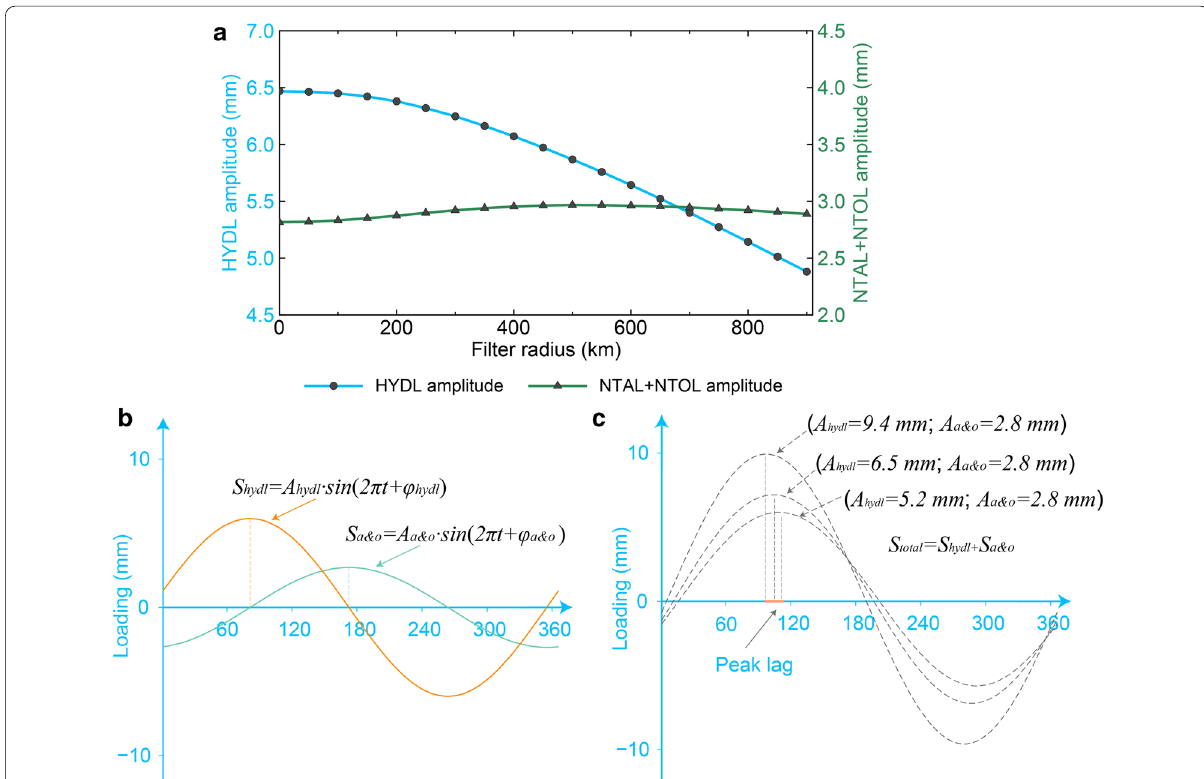
Fig. 8 Reason for the difference among the three products. a Relation between the amplitude of gravity recovery and climate experiment (GRACE)-dependent loading deformation and filter radius; b simulative signals of hydrological loading (HYDL) and non-tidal atmospheric loading (NTAL) non-tidal ocean loading (NTOL); c simulative signals of combined +